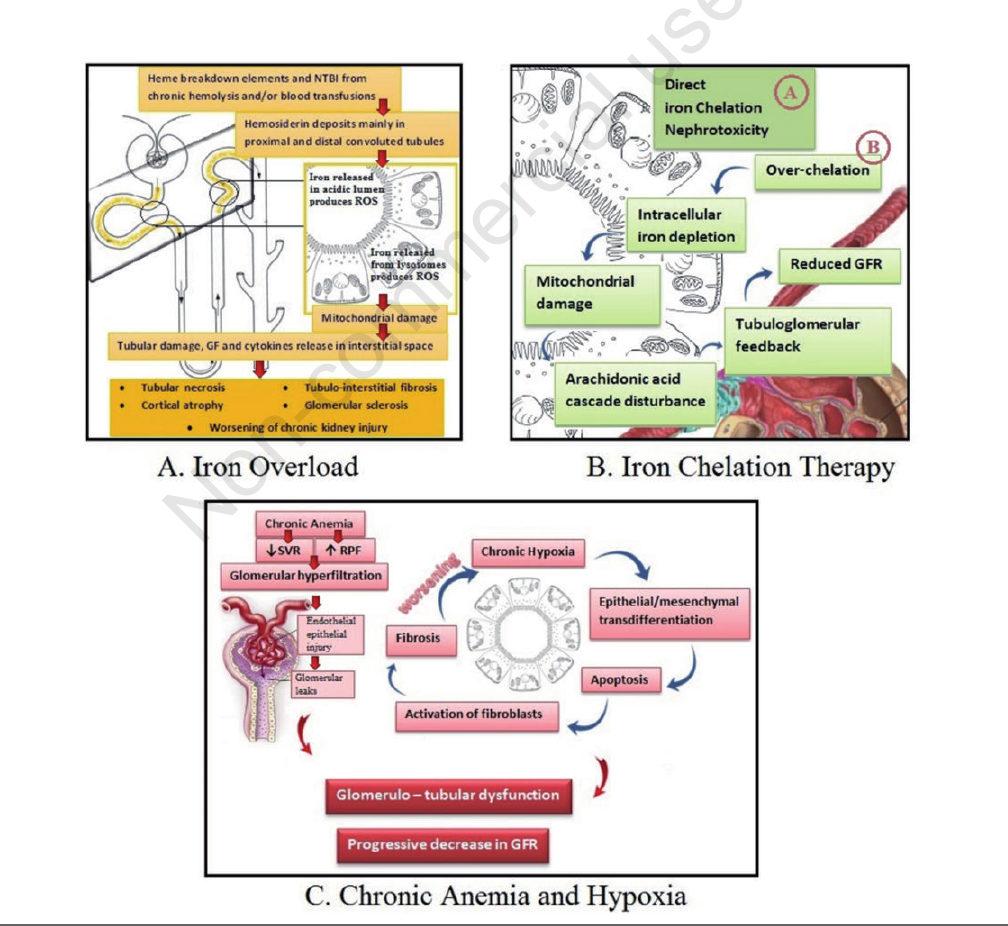
Figure 1. Pathophysiology behind the renal complications in thalassemia. (a) the suggested pathophysiology of renal disease due to iron overload; (b) two possible mechanisms for renal complications due to iron chelation therapy; (c) the impact of chronic anemia and hypoxia on kidney structure and function. NTBI, non transferrin bound iron; ROS, reactive oxygen species; GF, growth factor; GFR, glomerular filtration rate; SVR, systemic vascular resistance; RPF, renal plasma